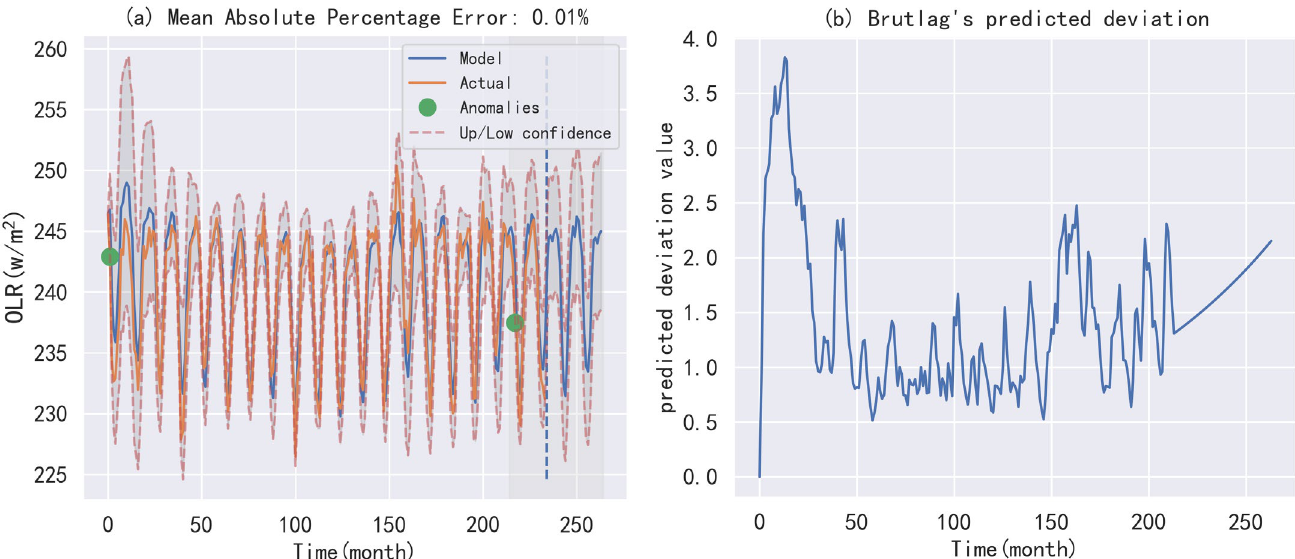
Figure 6. Triple-exponential smoothing analysis and prediction: ( a ) triple-exponential smoothing prediction results and ( b ) predicted deviation.